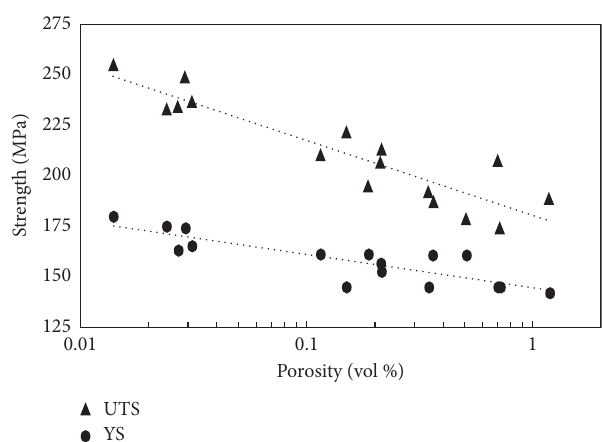
Figure 13: Effect of porosity volume fraction on the tensile properties of A356 alloy in the T6 condition [27].